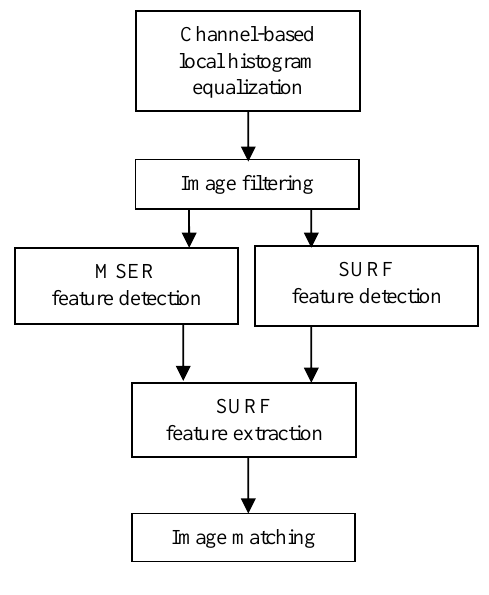
Figure 1. Process flow